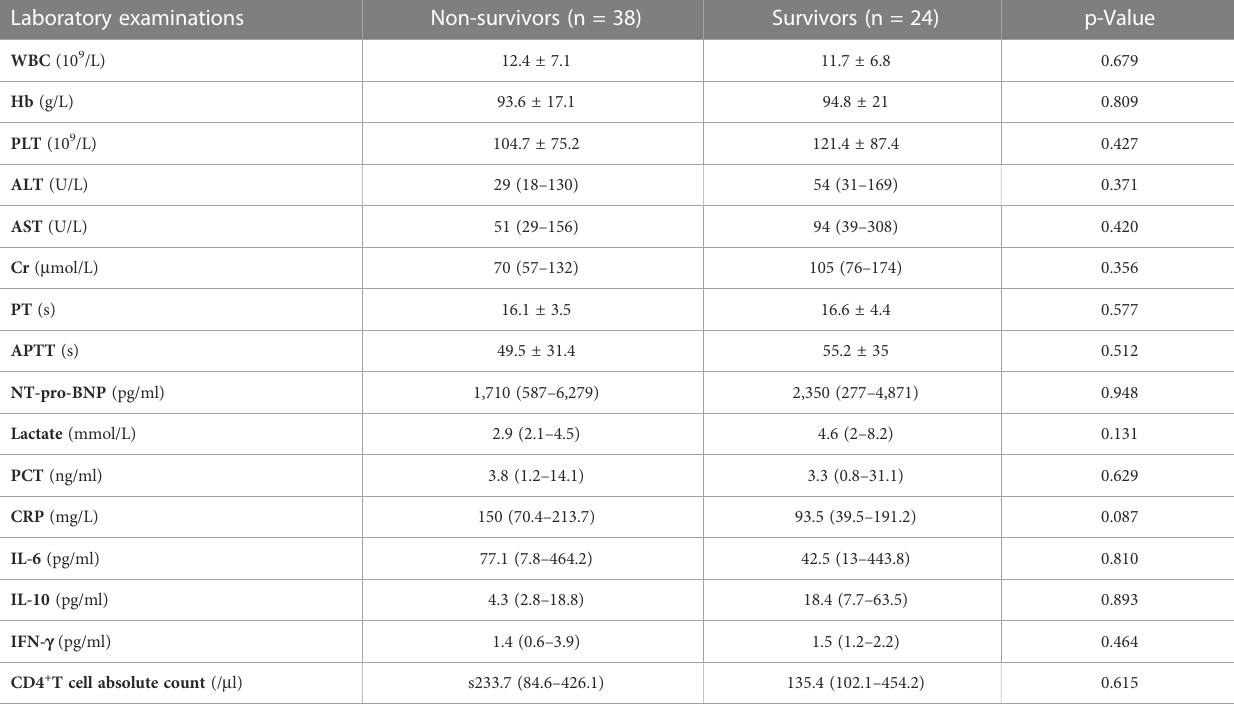
TABLE 3 Laboratory examinations of ECMO patients within 48 h after ECMO assistance.